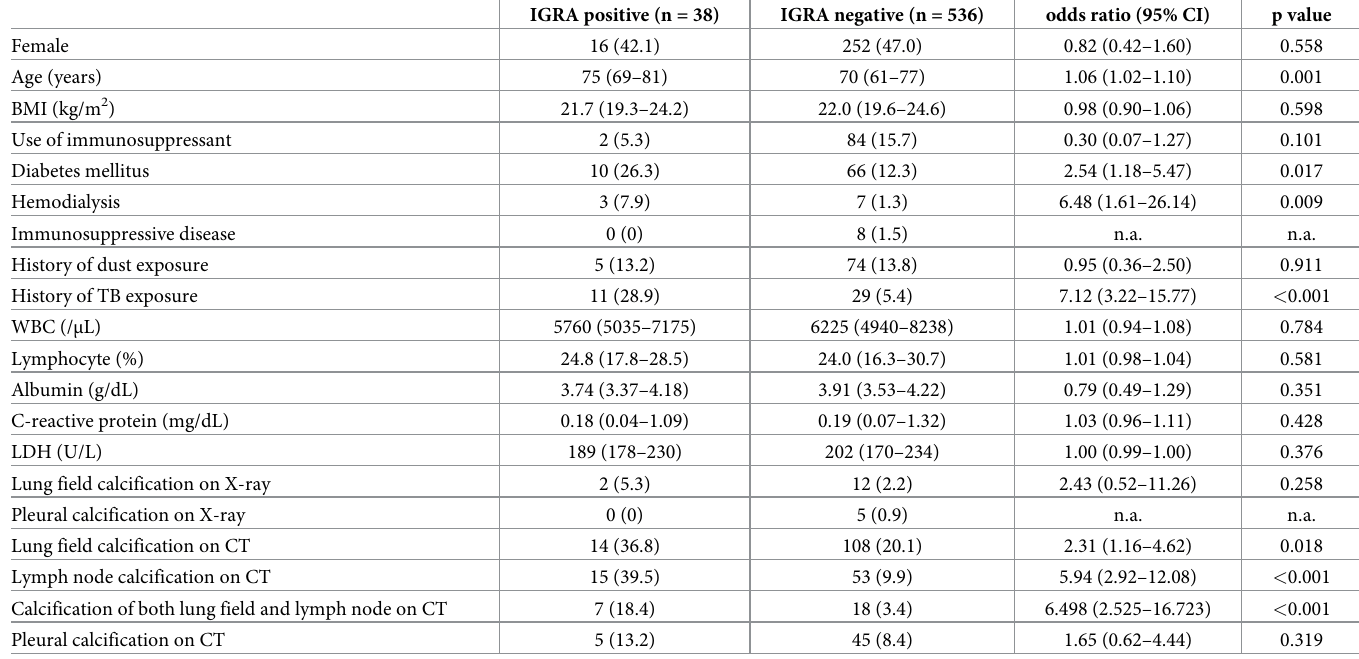
Table 2. Univariate analysis of the baseline characteristics and chest radiological features associated with positive IGRA results.